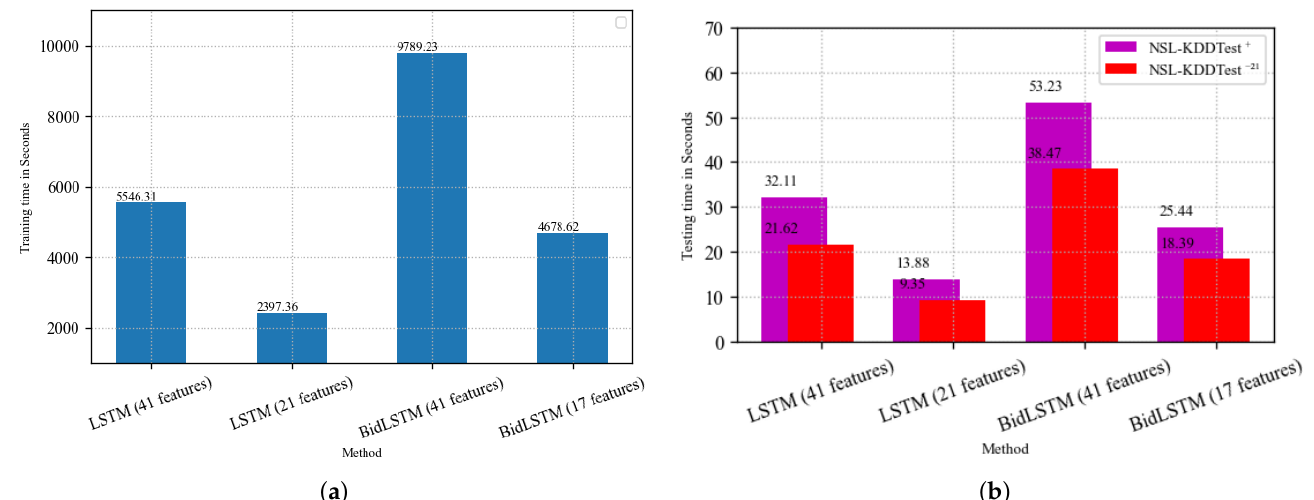
Figure 8. Training and testing times of the methods used in the study. ( a ) Training times of the various methods in seconds; ( b ) testing times of the various methods in